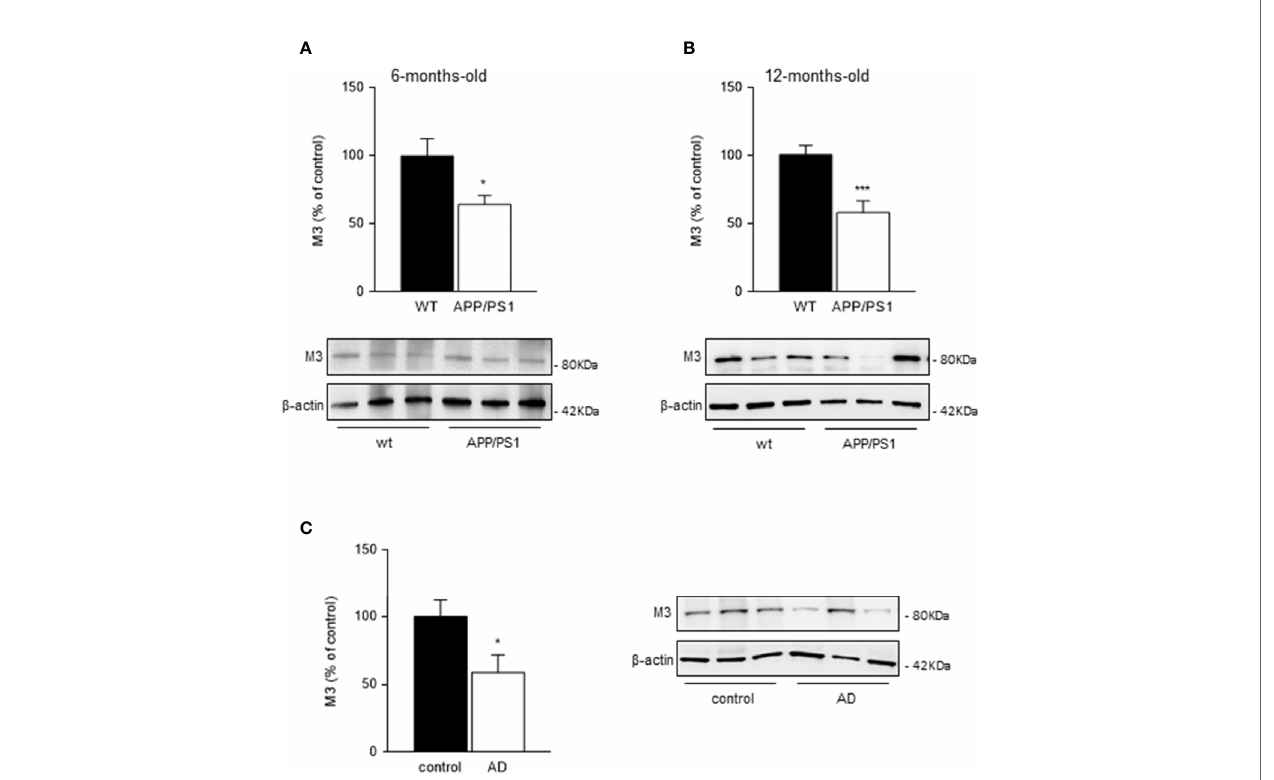
FIGURE 3 | Muscarinic M3 receptor levels in mice and human submandibular glands. (A, B) Western blot analysis showed reduced M3 receptor levels in submandibular glands from (A) 6- and (B) 12-month-old APP/PS1 compared with WT mice ( n = 8-13, per group). (C) In submandibular glands from AD patients, M3 receptor levels were also decreased compared with healthy control subjects ( n = 8-10, per group). Representative Western blots and histograms with their densitometric analysis are shown. Data are represented as mean ± SEM. Differences between groups were assessed using the Mann-Whitney test. *p < 0.05; ***p <